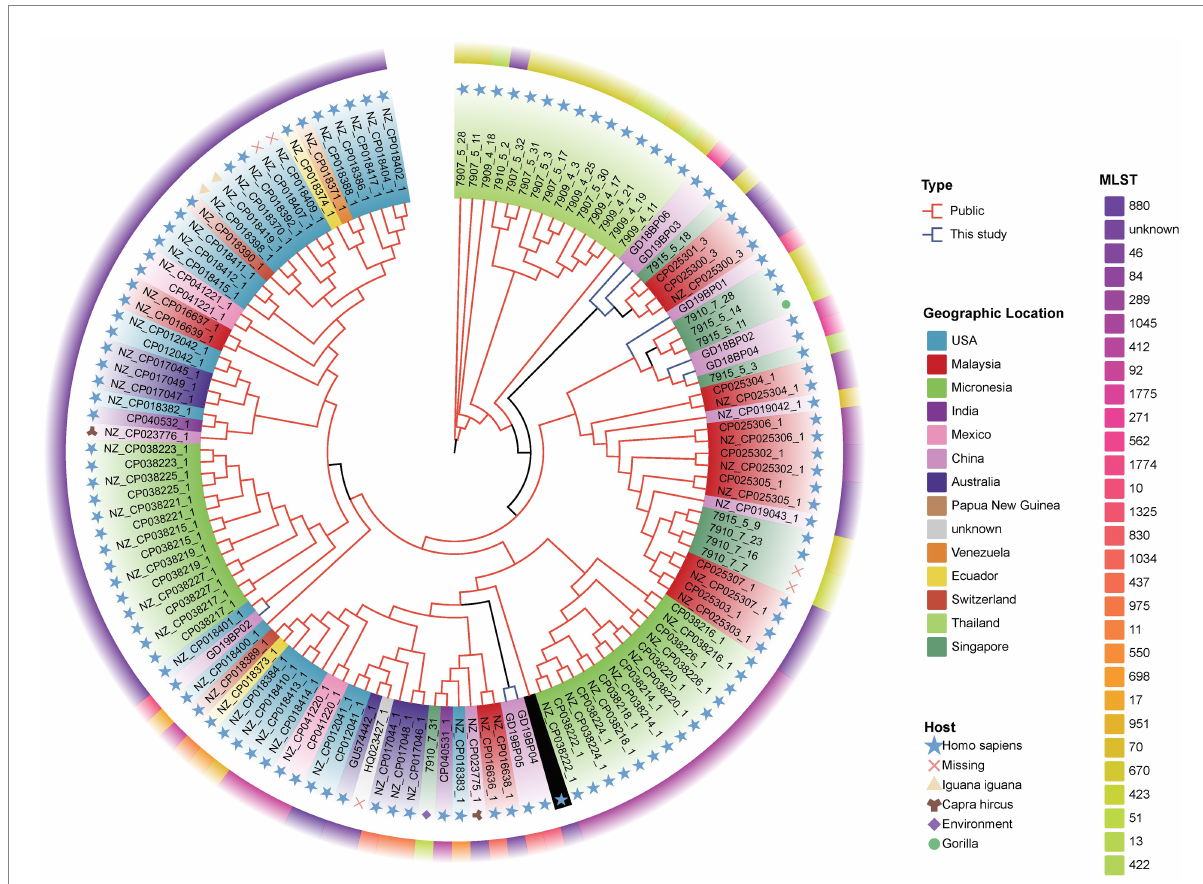
FIGURE 4 Phylogenomic comparison of Guangdong B. pseudomallei strains ( n = 8) with global B. pseudomallei reference strains ( n = 122). The maximum- parsimony phylogenetic tree was constructed from 119 B. pseudomallei genome sequences, including the eight genomes from this study. The inner circle with varying colors represents different countries. The colors in the middle circle show the MLST of each genomic isolate, while the outermost circle with different symbols displays the strain